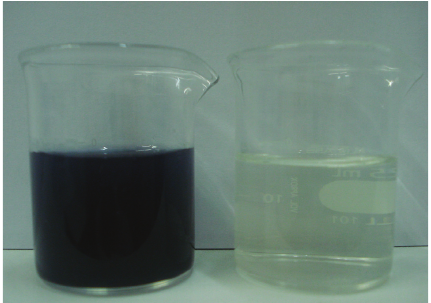
Figure 9: Images of the textile effluent before and after permeation through ceramic